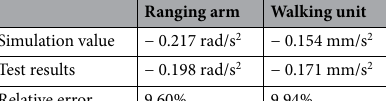
Ranging arm Walking unit Simulation value − 0.217 rad/s